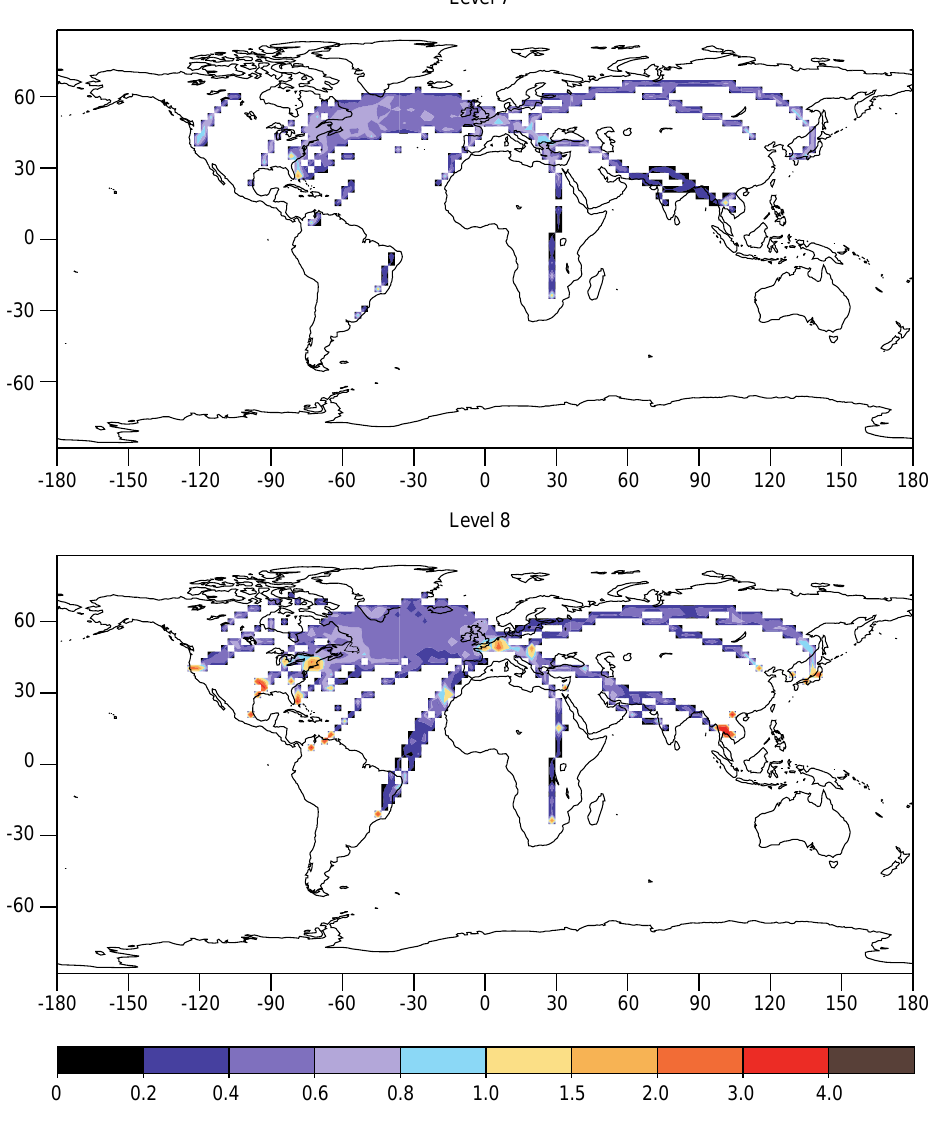
Fig. 2. Mean standard deviation of temperature in K. Mid-level pressures are 190 hPa for level 7 and 250 hPa for